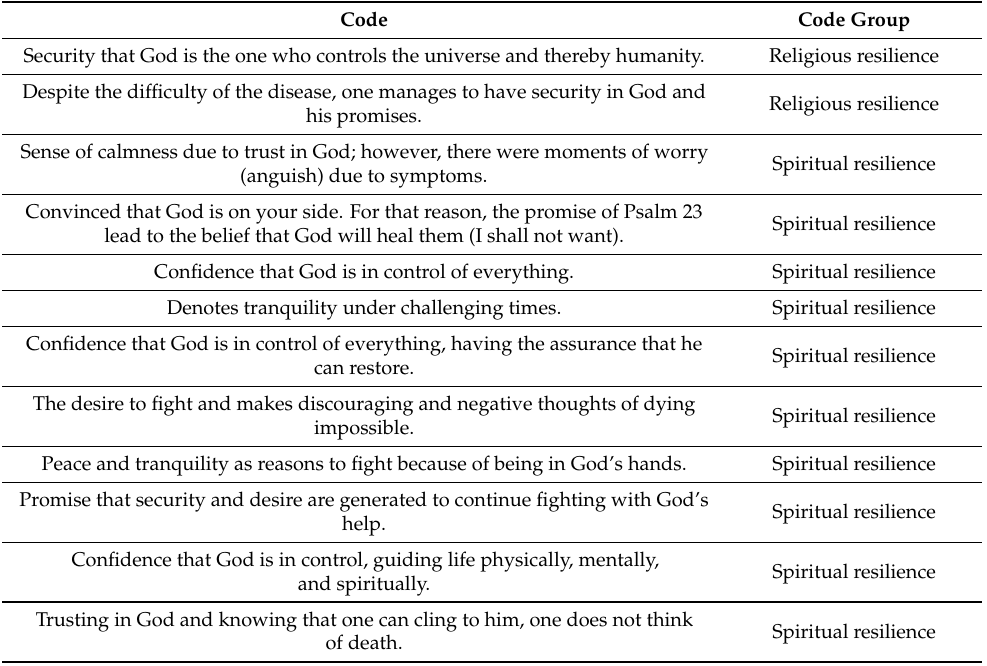
Table 10. Code group: religious